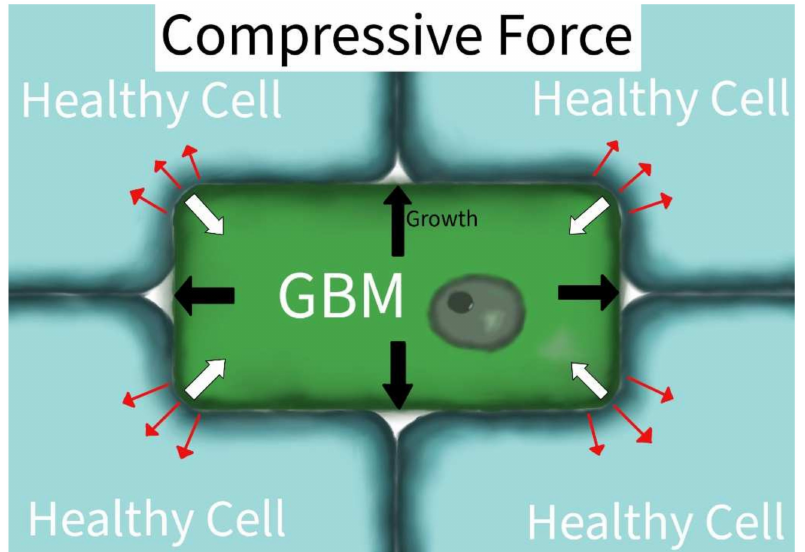
Figure 3. Compressive Force in GBM. The external environment will exert compressive forces on the GBM cell (white arrow vectors). When GBM grows in a fixed volume or is surrounded by immobile tissue (black arrows), it will also exert compressive forces on the surrounding tissue structure (red